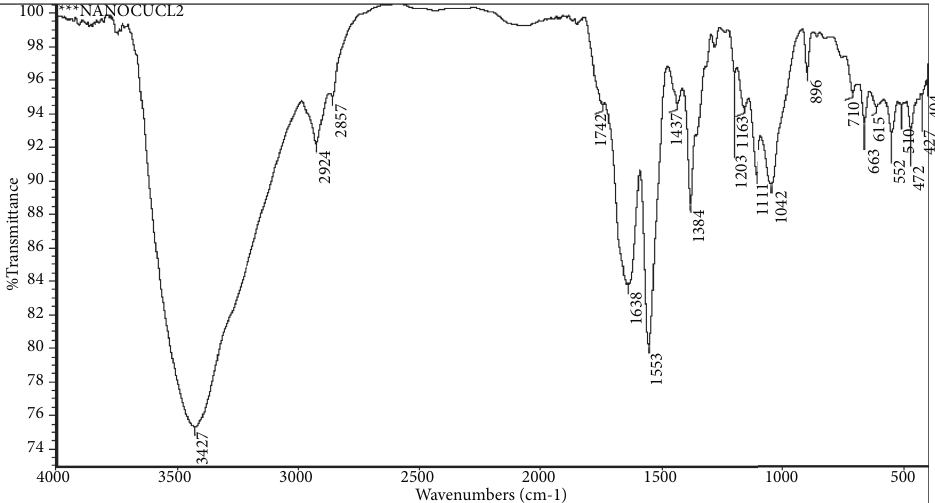
Figure 5: IR spectra of nano-Cu-CFT complex.